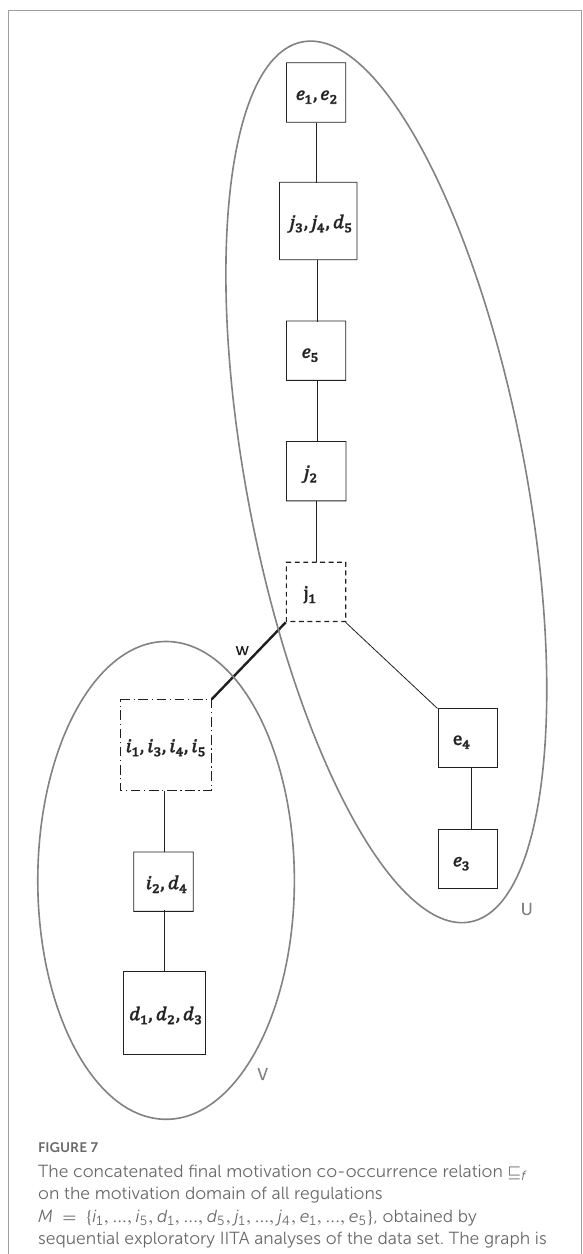
FIGURE7 The concatenated final motivation co-occurrence relation (cid:118) f on the motivation domain of all regulations M = { i 1 ,..., i 5 , d 1 ,..., d 5 , j 1 ,..., j 4 , e 1 ,..., e 5 } , obtained by sequential exploratory IITA analyses of the data set. The graph is composed of two, connected by w , chains U (of essentially controlled motivation) and V (of autonomous